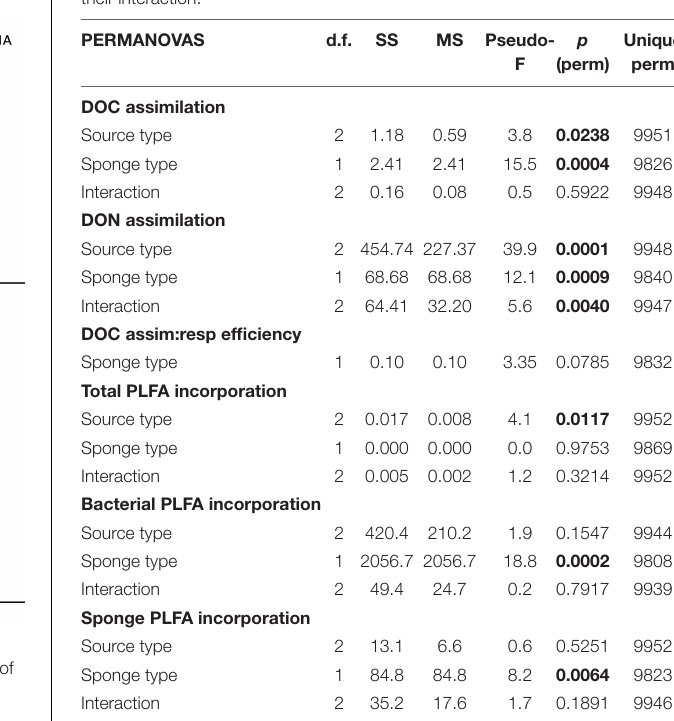
asterisks (*) indicate significant differences between LMA and HMA types within each source. Signif. codes: ∗∗ p < 0.01, ∗ p < 0.05.